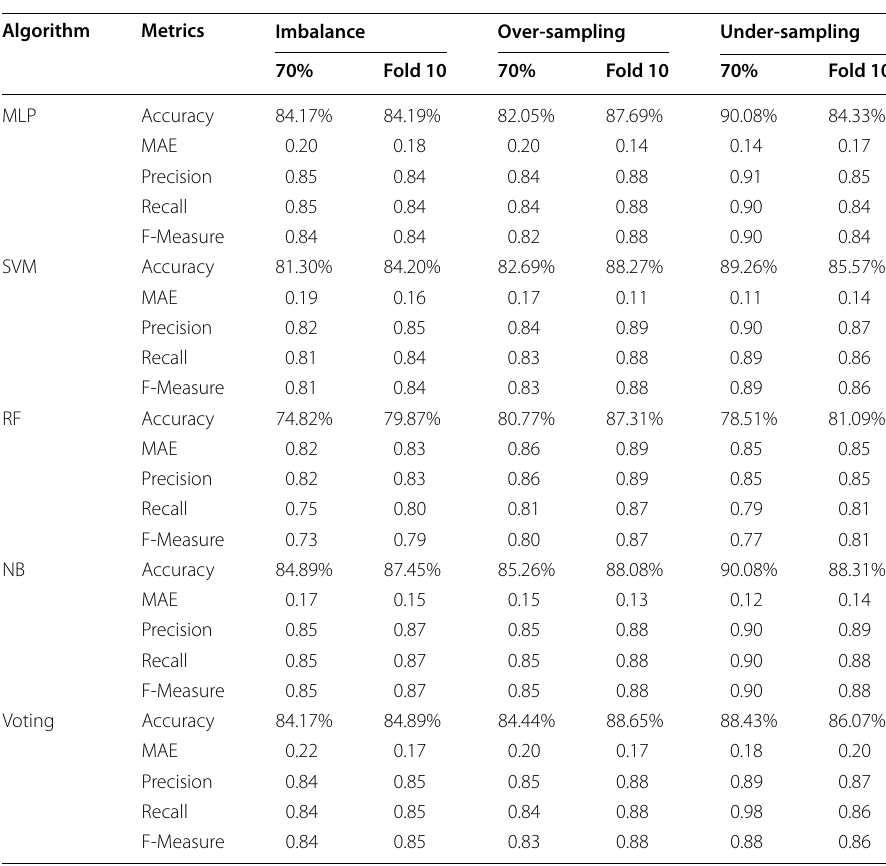
Table 12 Result of Twitter platform Twitter Algorithm